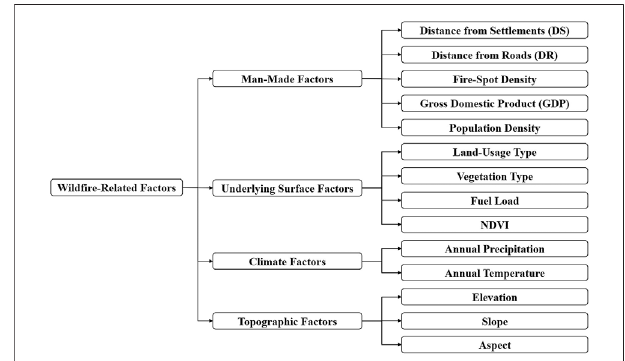
FIGURE 1 | Wild fi re-related factors classi fi